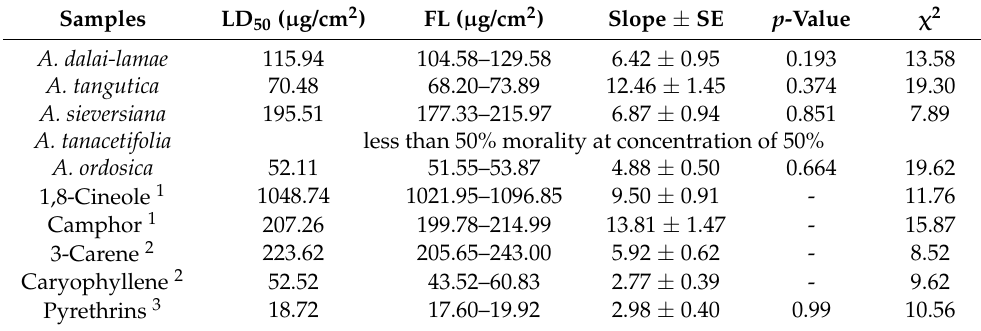
Table 3. Contact toxicity of the essential oils from five Artemisia species and major compounds against L. bostrychophila adults.